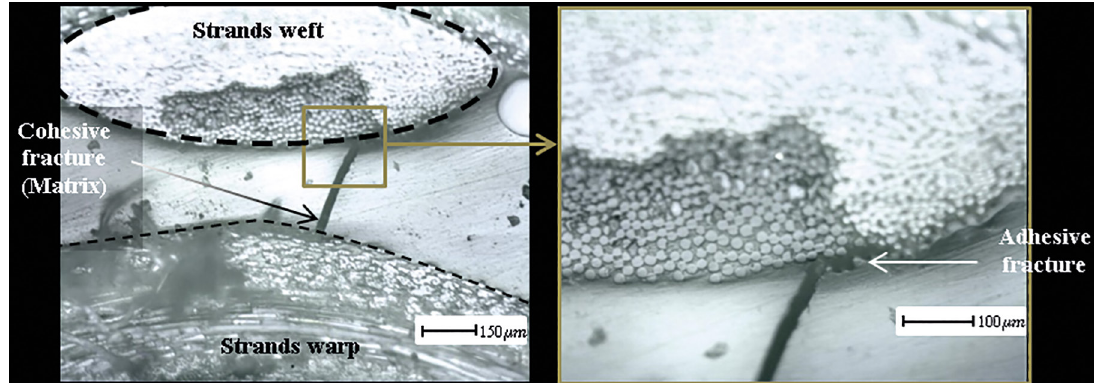
Figure 17. Fracture - HSCL